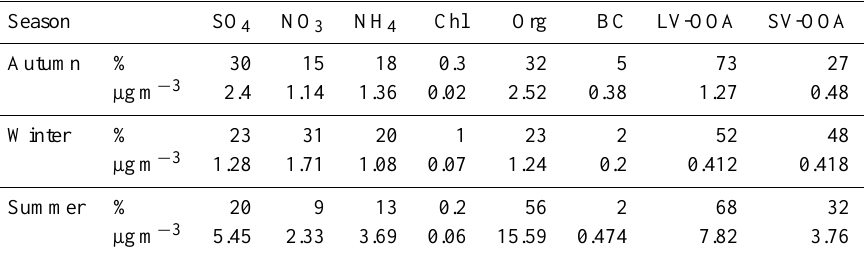
Table 2. The fractional contribution of each species to the total submicron particle mass (%) and their corresponding average mass concen- trations (µgm − 3 ). The value shown for each of the separated organic species (LVOOA and SV-OOA) is the fractional contribution of these species to the total